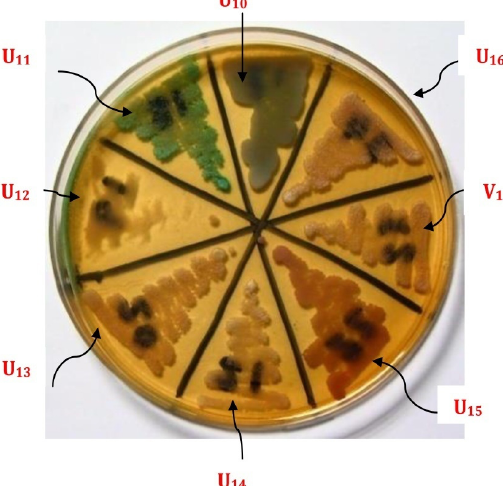
Figure A1. Saussurea costus root crude extraction and solvent-solvent fractionation scheme.